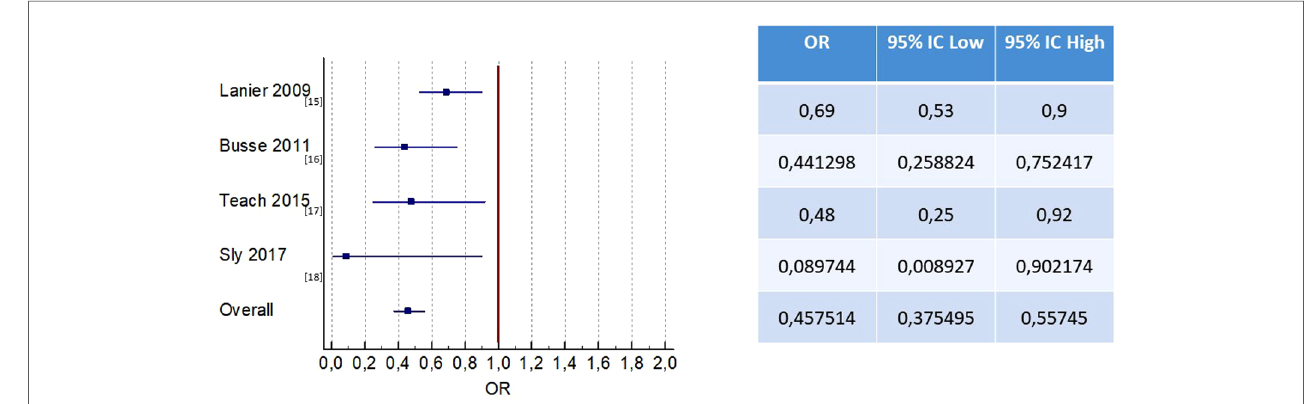
FIGURE 2 Effect of omalizumab vs. placebo on the number of exacerbations.